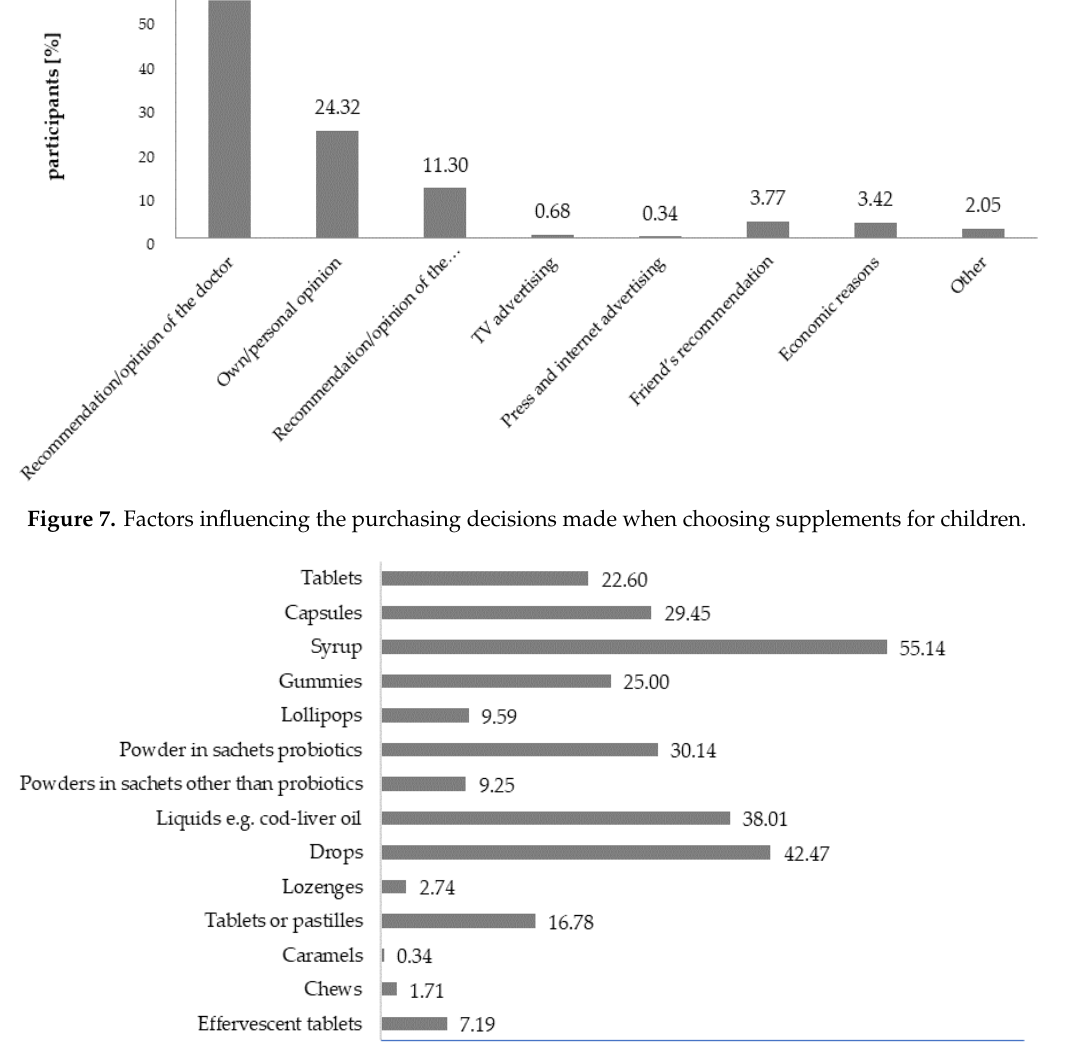
Figure 8. Formulations of dietary supplements intended for children favored by the consumers. Values do not add up to 100%, due to the fact that more than one answer was allowed.